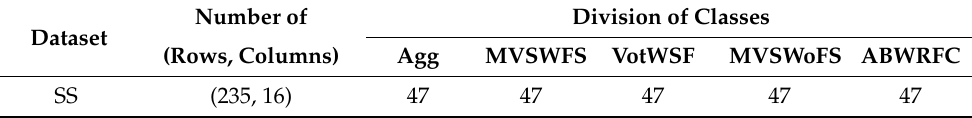
Table 5. Final SS dataset.